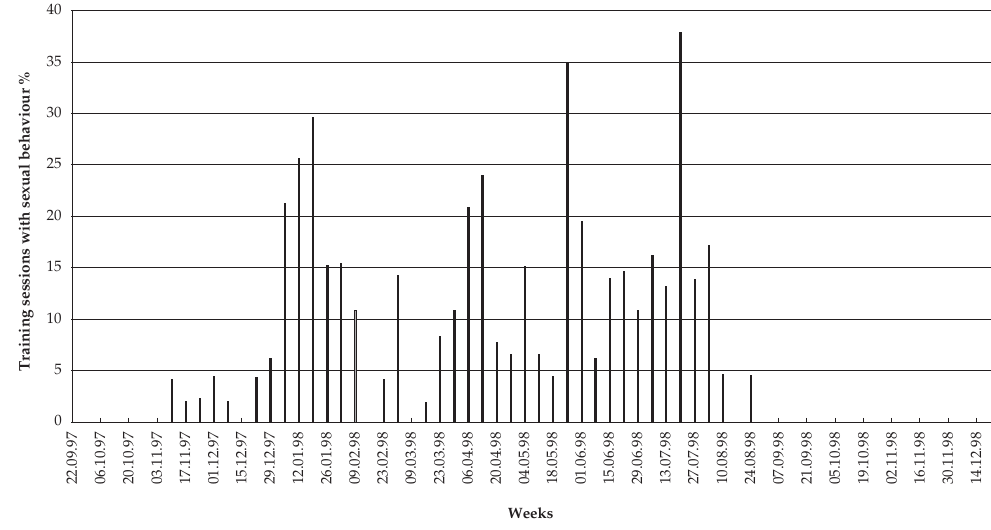
Fig. 5. Occurrence of sexual behaviour during training sessions between September 1997 and December 1998, expressed as the weekly percentage of training sessions where sexual behav- iour was observed.